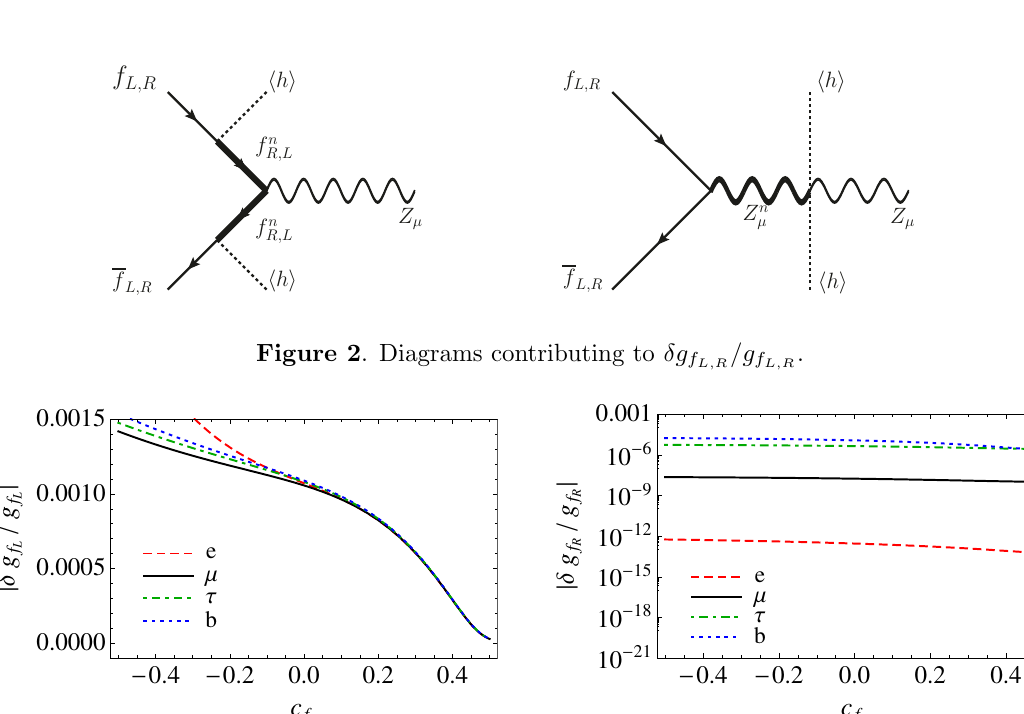
(cid:14)g f =g f (right panel) from KK modes for R R j j . 10 (cid:0) 3 . We (cid:14)g f =g f L;R L;R j j